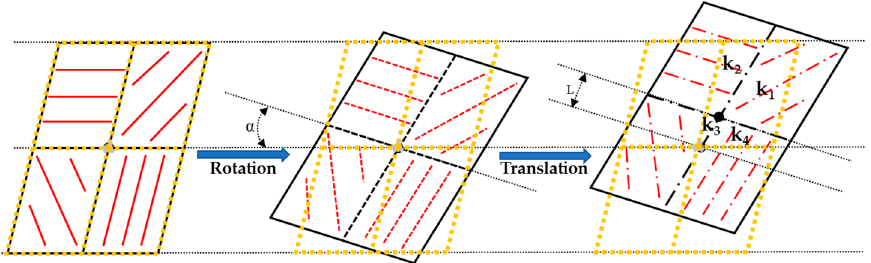
Figure 2. The polarizer installation misalignment of one polarization unit.